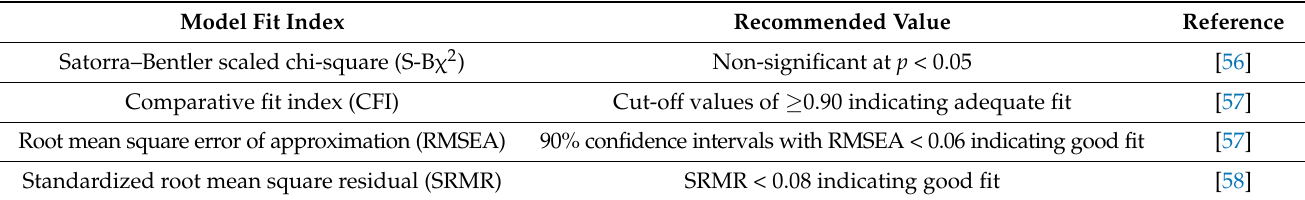
Table 1. Criteria for goodness-of-fit.